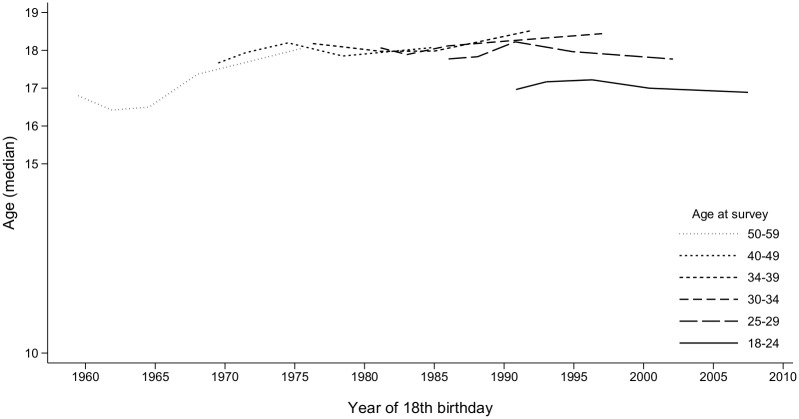
Median age at first sexual intercourse with a man.Surveys in 1995–2011, respondents aged 18–59. Reading: Respondents aged 25–29 surveyed in 1995 had turned 18 in 1986 on average and had a median age at first intercourse with a man equal to 17.8. Lines are drawn only when the generation is composed of at least 30 respondents.